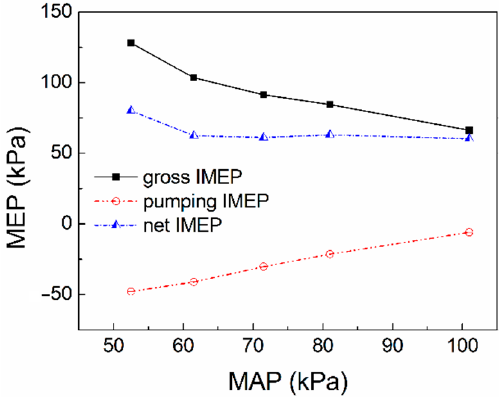
Figure 5. Indicated mean effective pressure under the various MAPs.